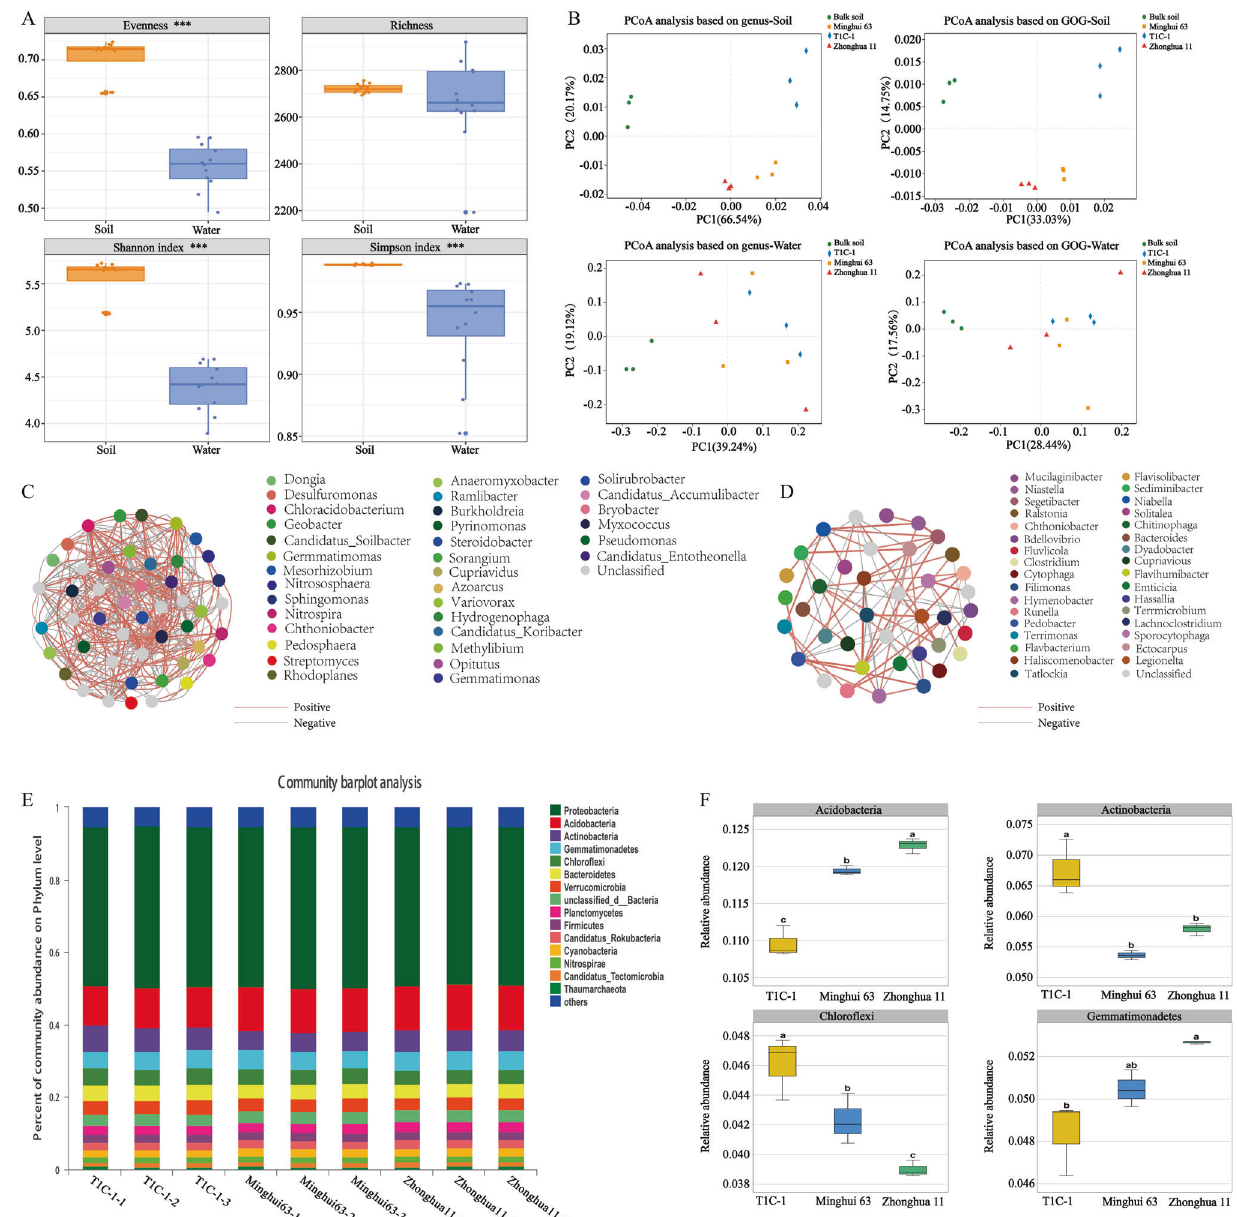
Fig. 2 Comparison of soil and surface water shotgun metagenomic sequencing data. A Differences in α -diversity metrics, Shannon – Wiener index ( H ′ ), Simpson index ( D ), Richness ( R ), and Evenness ( E ) between soil and surface water communities. Black asterisks indicate that the α - diversity index was signi fi cantly higher in soils ( *** , p < 0.001; Wilcoxon rank sum test). B Principal coordinates analysis (PCoA) of soil and surface water sample community differences based on Bray – Curtis distances among metagenomic pro fi les. Co-occurrence networks based on Spearman ’ s correlation analysis of the abundances for the 50 most abundant microbial genera in soils ( C ) and surface waters ( D ). E Relative abundances (%) of the major bacterial phyla present in rhizosphere microbial communities. F Bacterial phyla with signi fi cantly different ( p < 0.05) abundances in soils among different rice varieties. Bars with different letters are signi fi cantly different ( p <